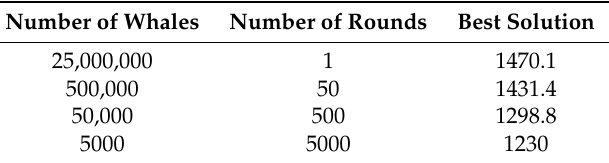
Table 11. The best solution of DS 5 for di ff erent modes.